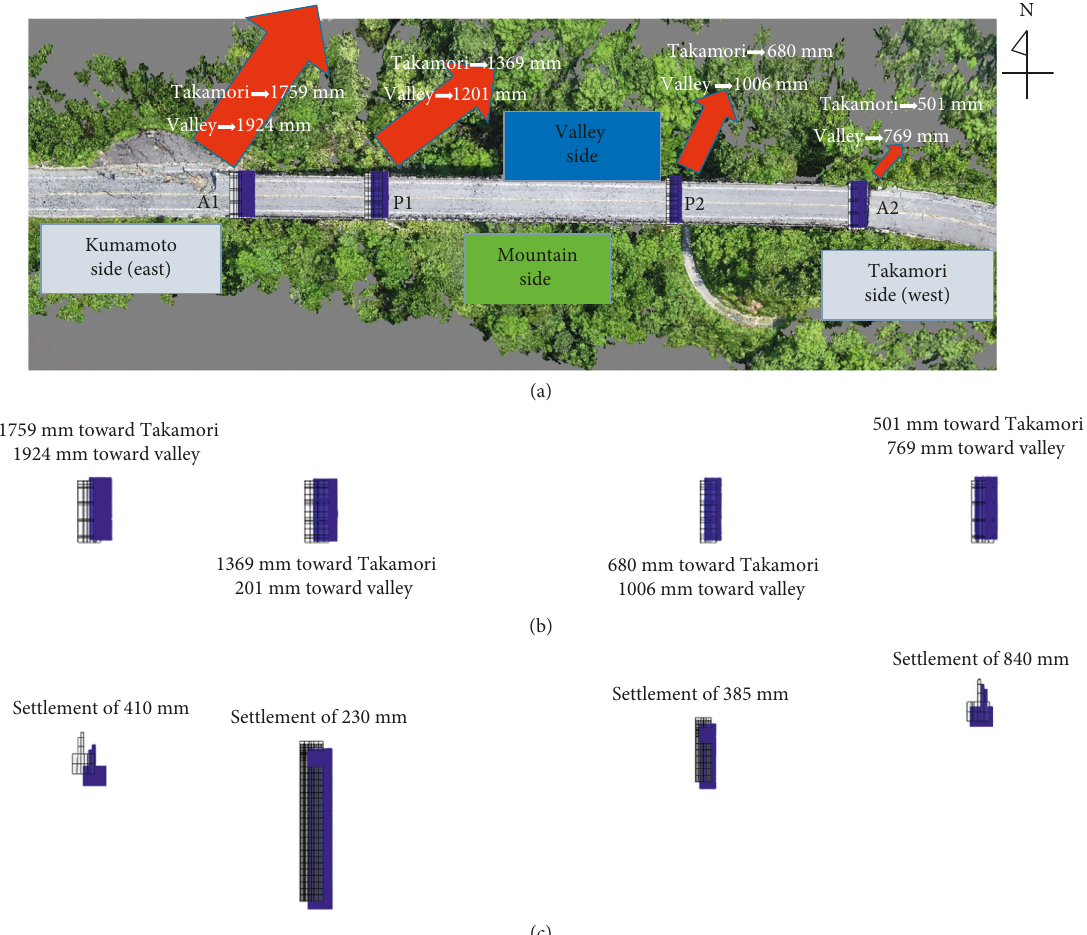
Figure 11: (a) Overall deformation of Tawarayama Bridge, (b) horizontal displacement of abutments and piers, and (c) settlement of abutments and piers.